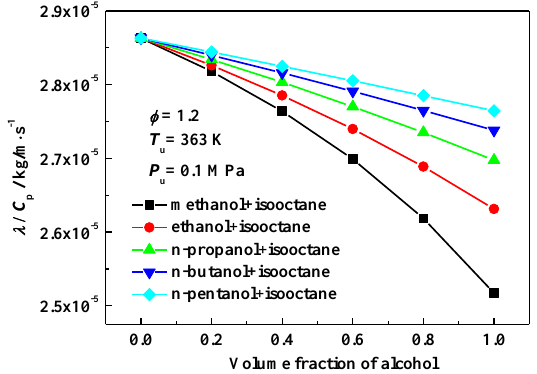
Figure 5. Density-compensated thermal diffusivity of alcohol-isooctane blend-air mixtures at 363 K, 0.1 MPa and the equivalence ratio of 1.2.